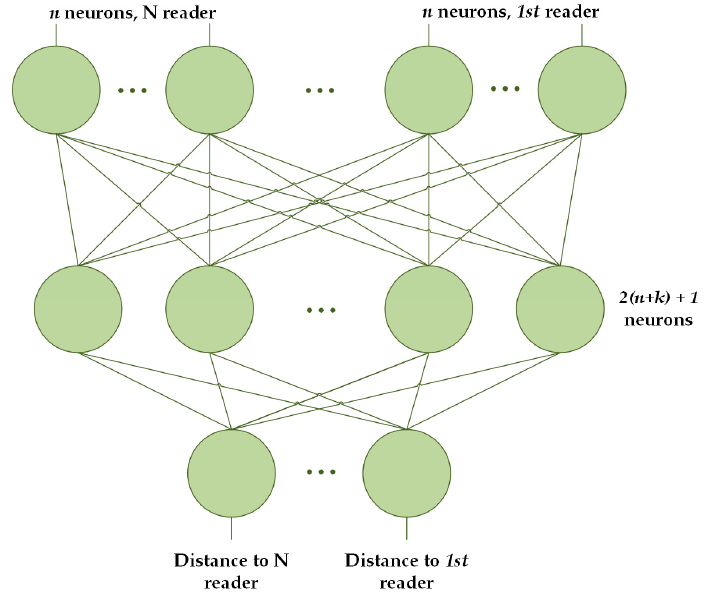
Figure 5. A schematic diagram of the two paths that follow the training and the real-time data: the